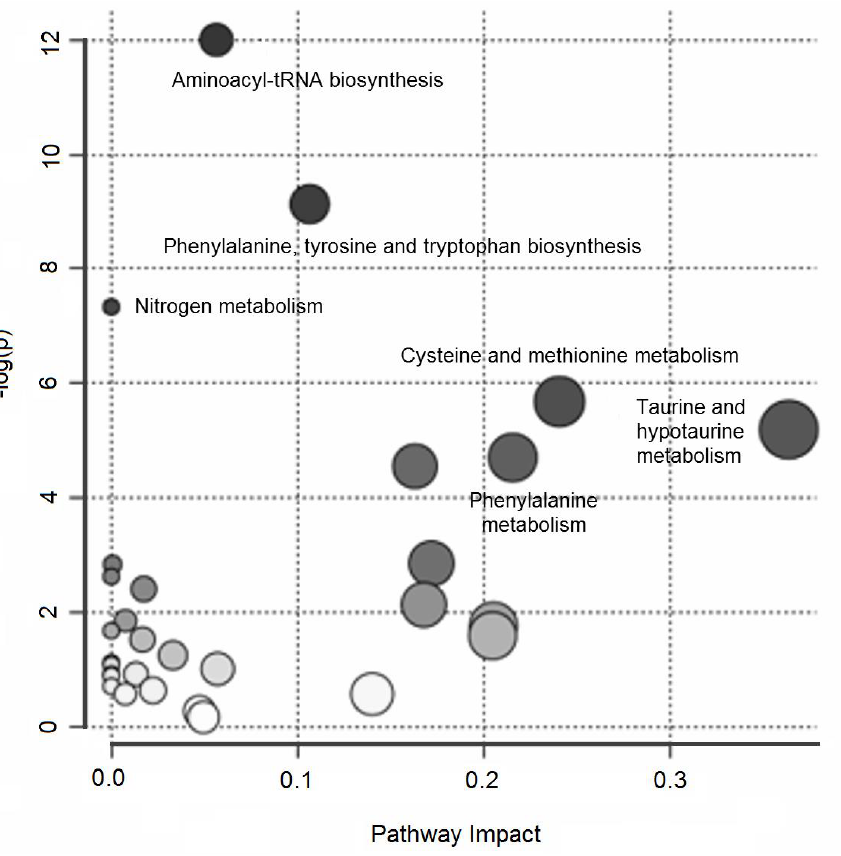
Figure 2. Untargeted metabolic profiling of urine samples: over-representation pathway analysis. The impact of each perturbed pathway is shown against its negative log p -value (-log( p )). The names of the pathways with a q- value less than 0.15 are shown in the